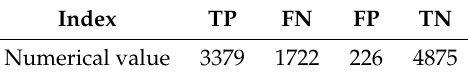
Table 20. Forecast indices value.